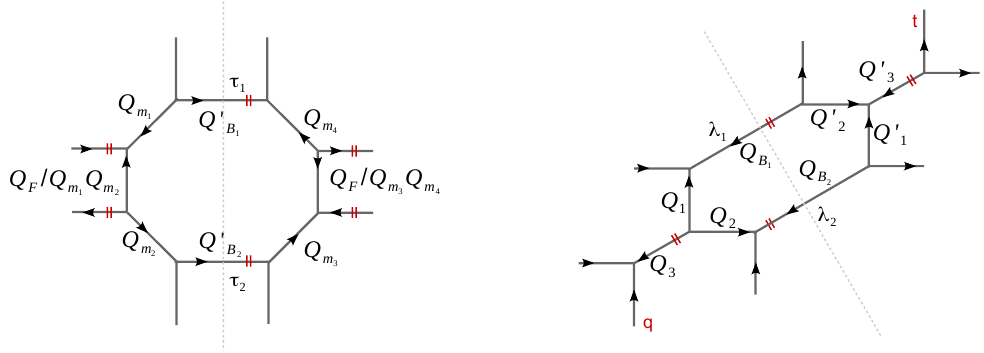
Figure 13 . Brane diagrams corresponding to the N = 1, SU(2) four-(cid:13)avour theory in 5D, con- structed by gluing strips ( left) and two T 2 webs ( right). Both the preferred direction and K(cid:127)ahler parameters are also